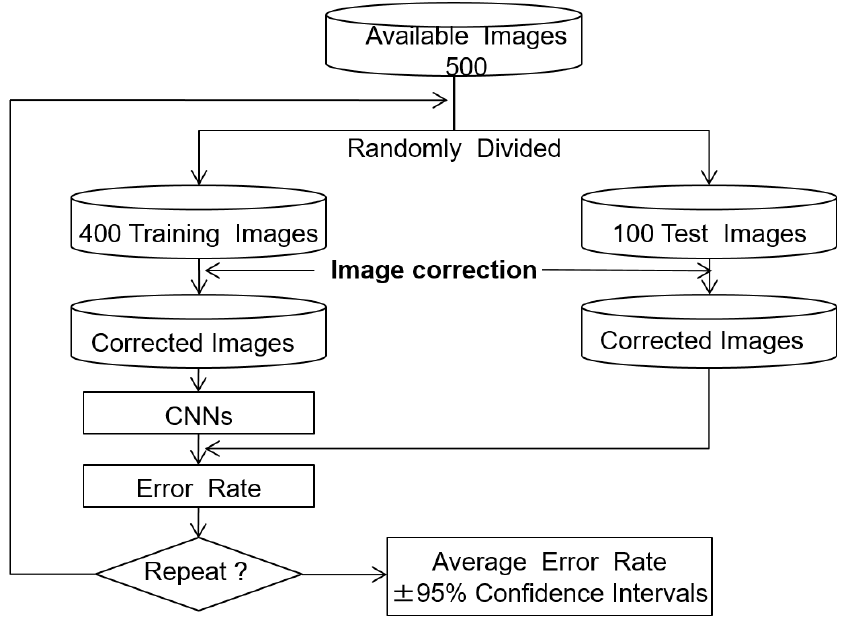
Figure 6. Error rate estimation with the holdout method.